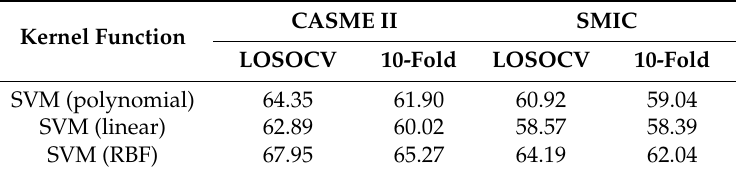
Table 4. Recognition rate of different kernel functions on CASME II and SMIC database